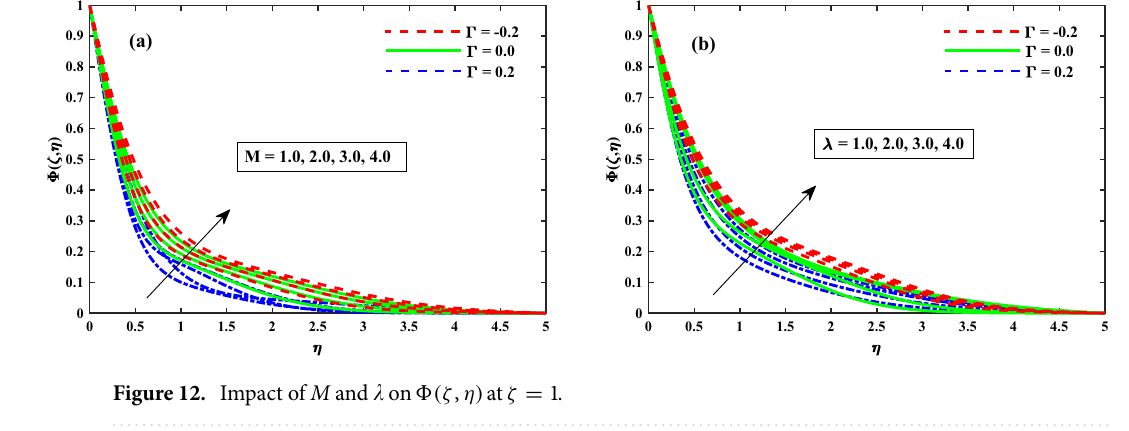
Figure 12. Impact of M and (cid:31) on �(ζ , η) at ζ